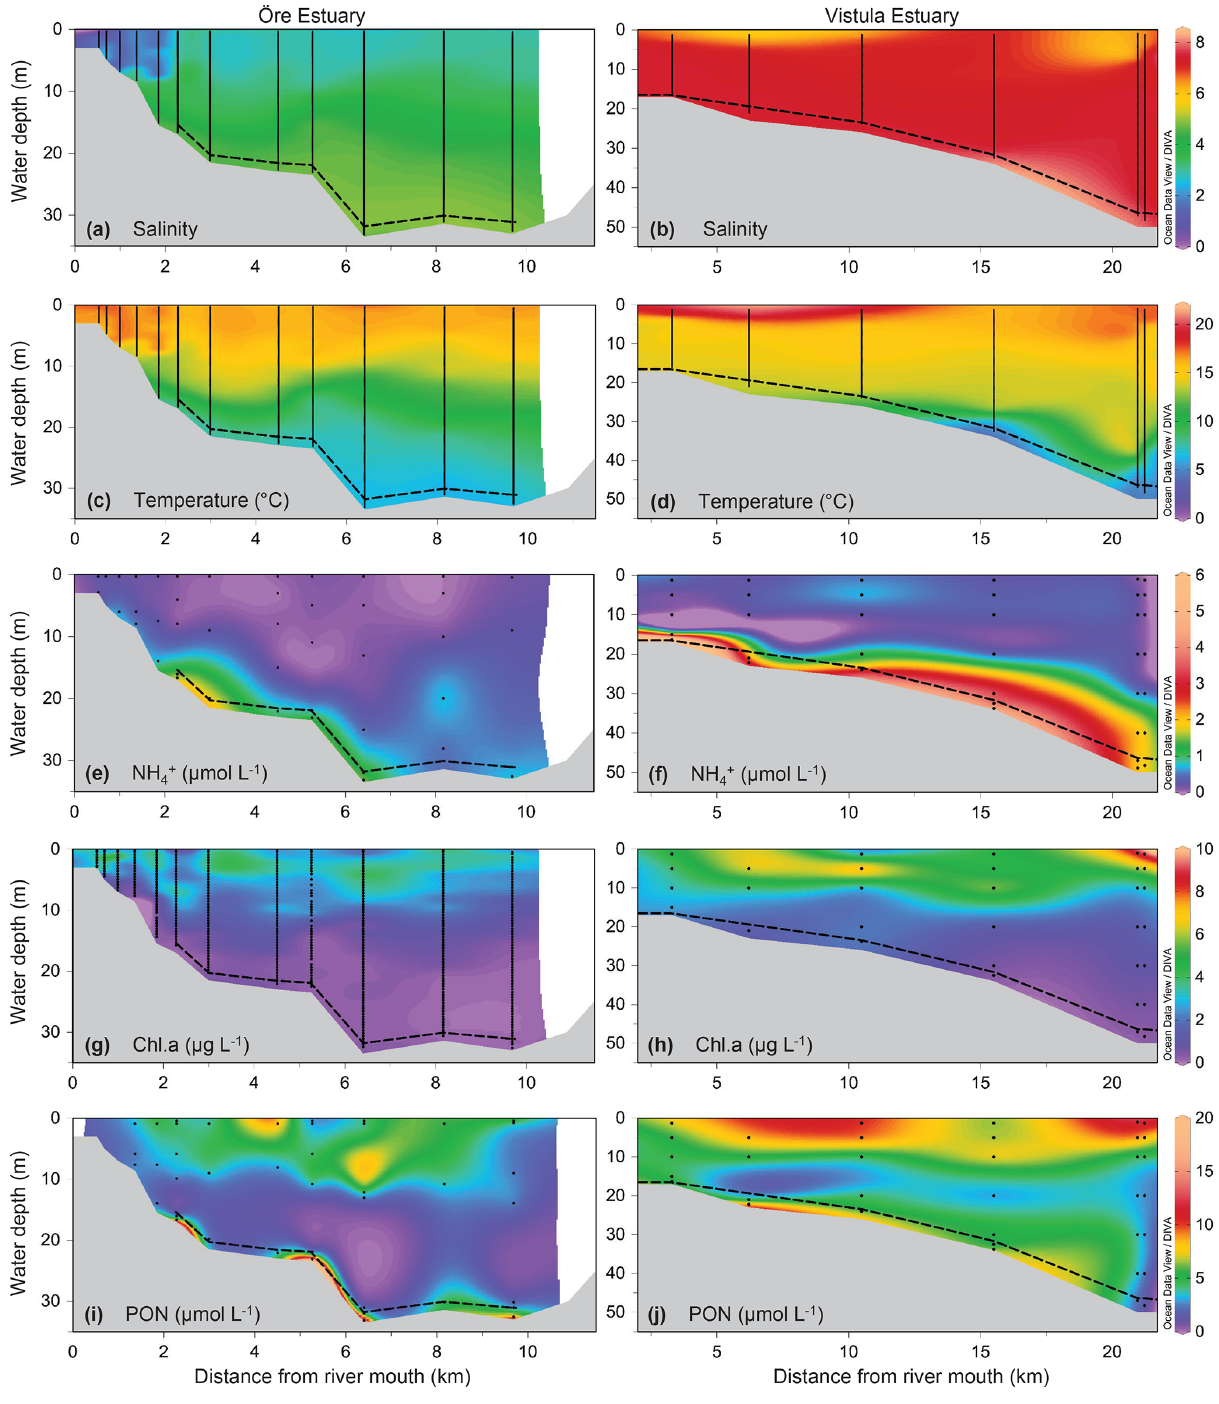
Figure 3. Same as Fig. 2 for the summer